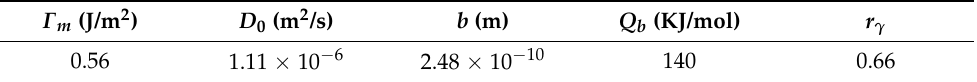
Table 1. Parameters of CA model for grain growth during directional annealing, data from